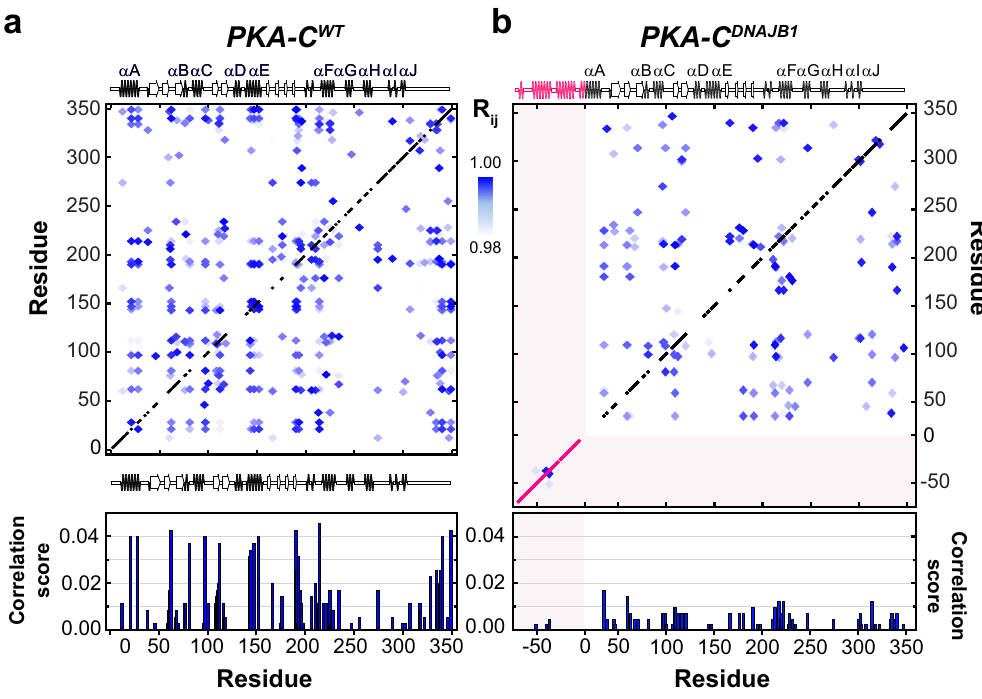
Fig. 3 Defective internal allosteric network of PKA-C DNAJB1 . Chemical shift correlation matrices for a PKA-C WT and b PKA-C DNAJB1 . The cross-peaks represent pairs of residues with the absolute value of the Pearson ’ s coef fi cient ≥ 0.98. The secondary structures for the two kinases are reported above and below the matrix. The bar graphs shown below each matrix report the average correlation scores per residue (see Methods